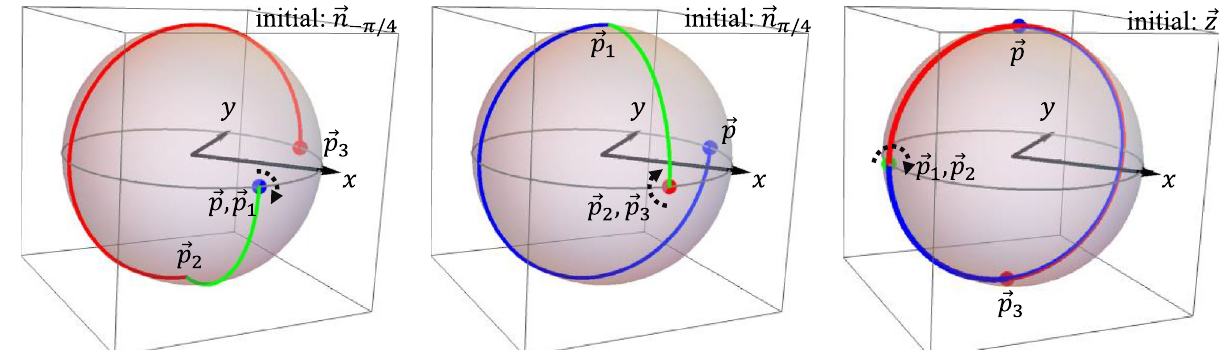
n π/ 4 , (cid:31) n π/ 4 , and (cid:31) z as � −